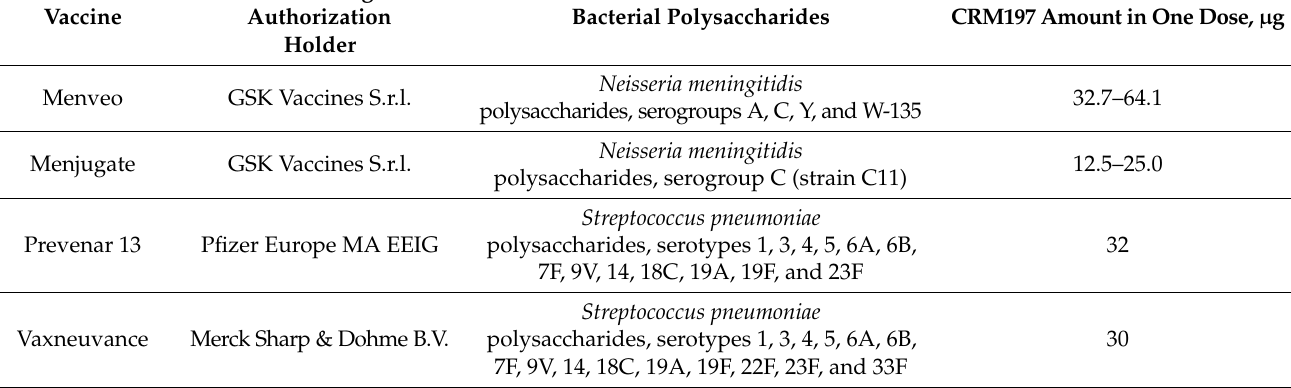
Table 1. CRM197 amounts in several conjugate